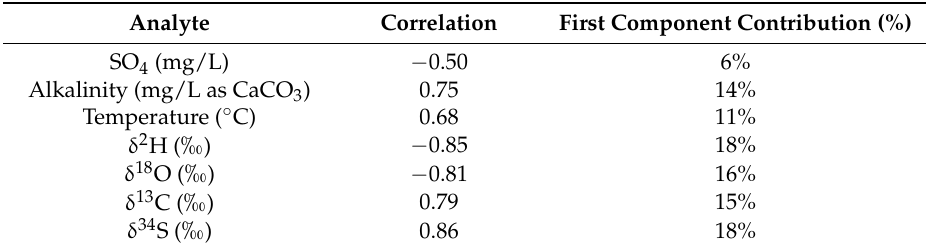
Table 4. Principal components analysis results for groundwater data from wells in the South Fork Palouse River Basin. Listed parameters include only those that explained >5% of the variance of the first component. Analyte Correlation First Component Contribution (%) SO 4 (mg/L) − 0.50